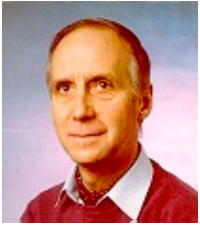
Figure 1. Howard Flack, courtesy of his widow Evelyne.